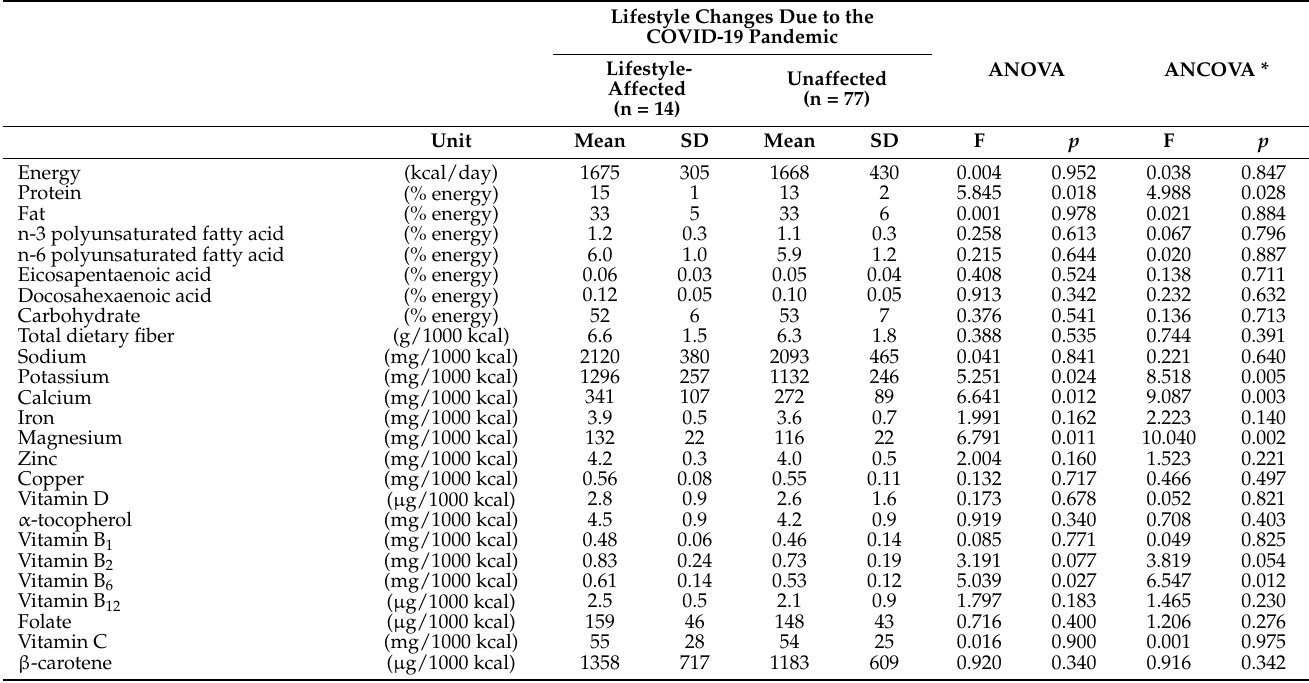
Table 3. Differences in nutrient intake between the lifestyle-affected and unaffected groups in primiparas (n =